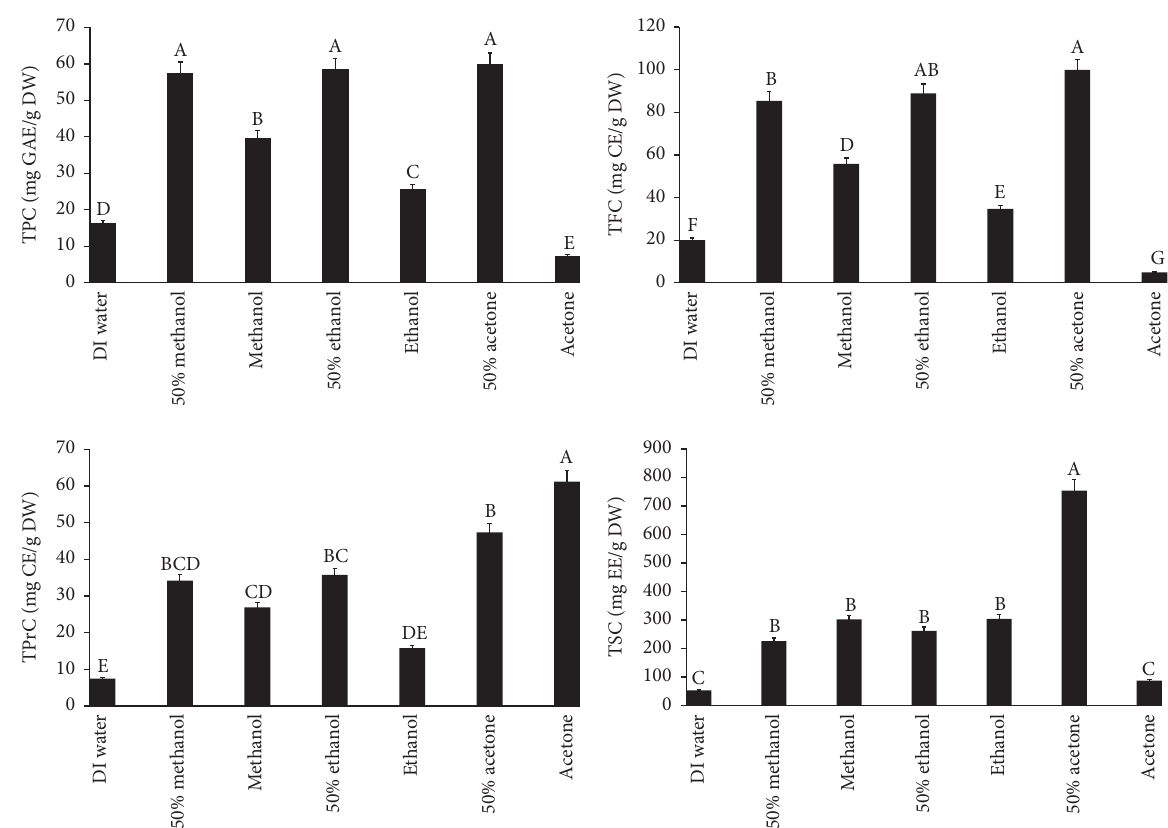
Figure 2: Effect of solvents on recovery of total phenolics (TPC), flavonoids (TFC), proanthocyanidins (TPrC), and saponins (TSC) from the root of S. chinensis . The values are the mean of three replications for each solvent ± standard deviation. Columns not sharing the same superscript letter are significantly different 𝑝 < 0.05 (DI water: deionized water, GAE: gallic acid equivalent, CE: catechin equivalent, EE: escin equivalent, and DW: dry